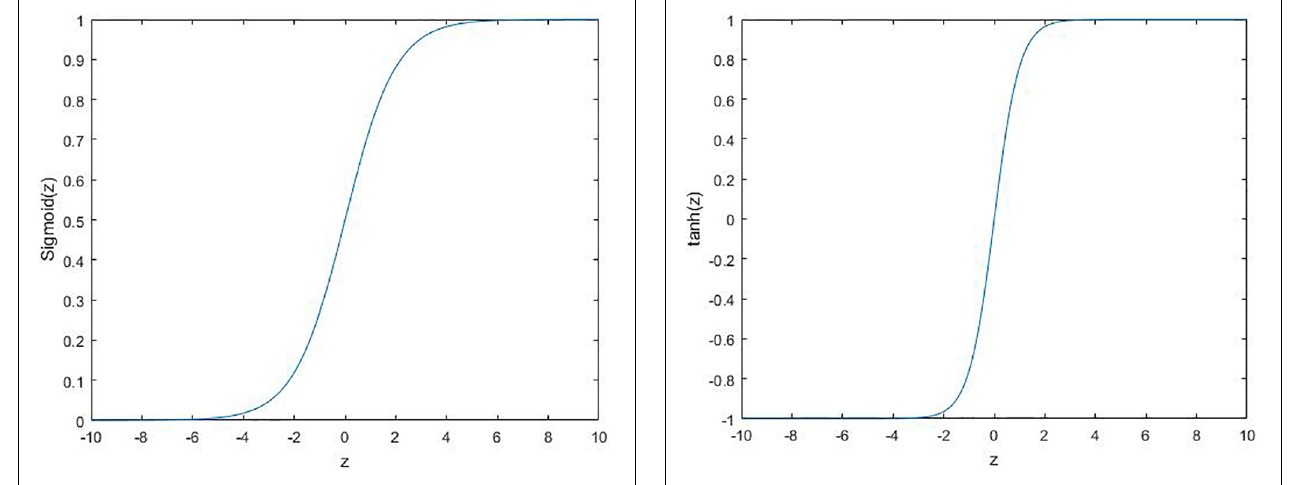
FIGURE 2 | Sigmoid function: f ( z ) = 1